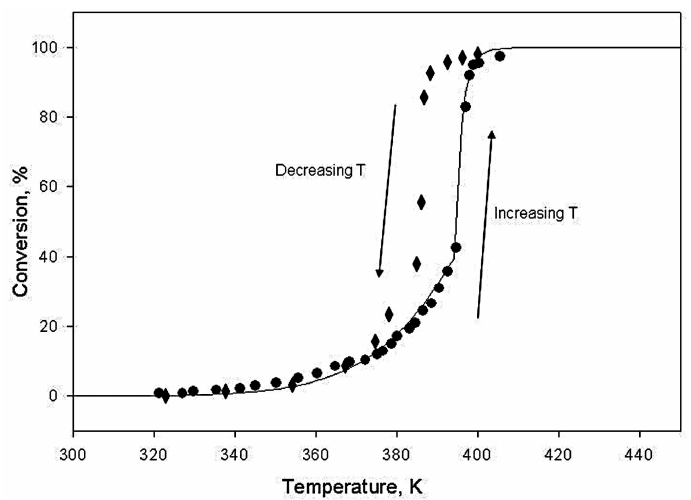
Figure 4. Hysteresis of the dependence of the degree of carbon monoxide conversion on temperature for the catalyst SnO 2 –PdO x . Circles correspond to increasing temperature, rhombs—decreasing temperature,